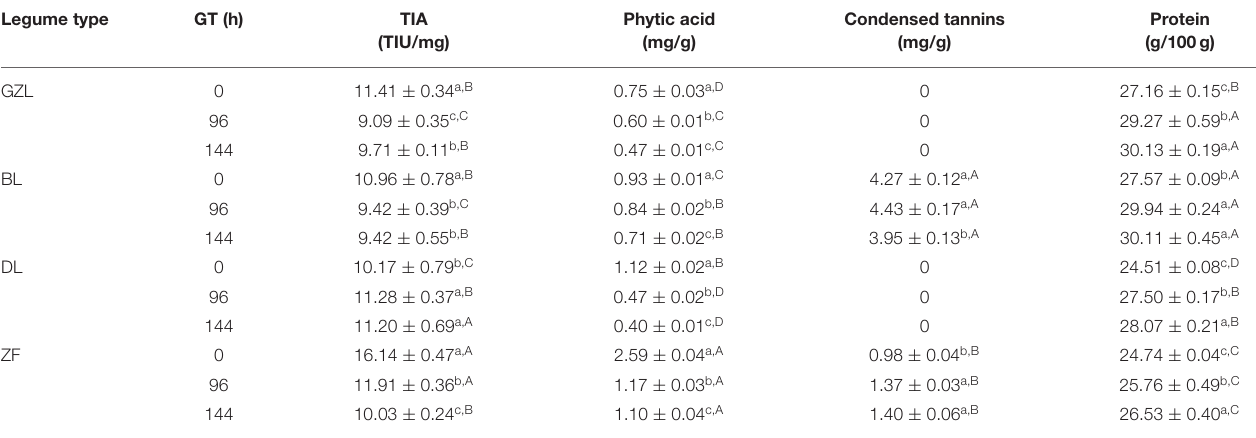
Data are the mean ± SD of the three replicates. Different lowercase letters within a column indicate statistical differences among different germination endpoints (p ≤ 0.05 post-hoc Duncan’s test). Different uppercase letters denote statistical differences among legumes at the same germination time (p ≤ 0.05 post-hoc Duncan’s test). BL, beluga lentil; DL, dehulled red lentil; GT, germination time; GZL, gray zero-tannin lentil; TIA, trypsin inhibitory activity; TIU, trypsin inhibitory units; ZF, low tannin/zero vicine–convicine fava